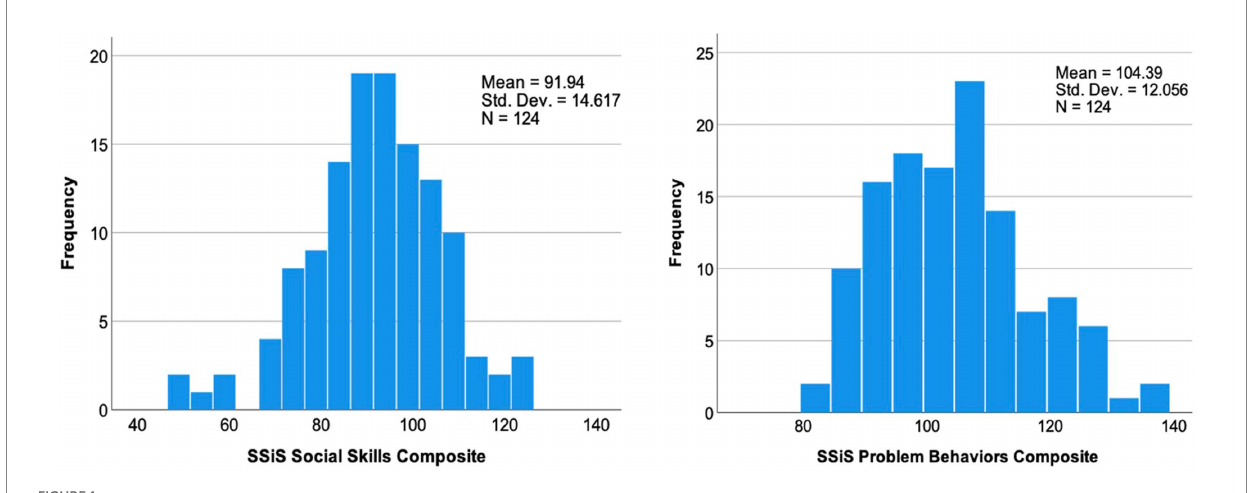
FIGURE 1 Distribution of Social Skills Improvement System (SSiS) composite